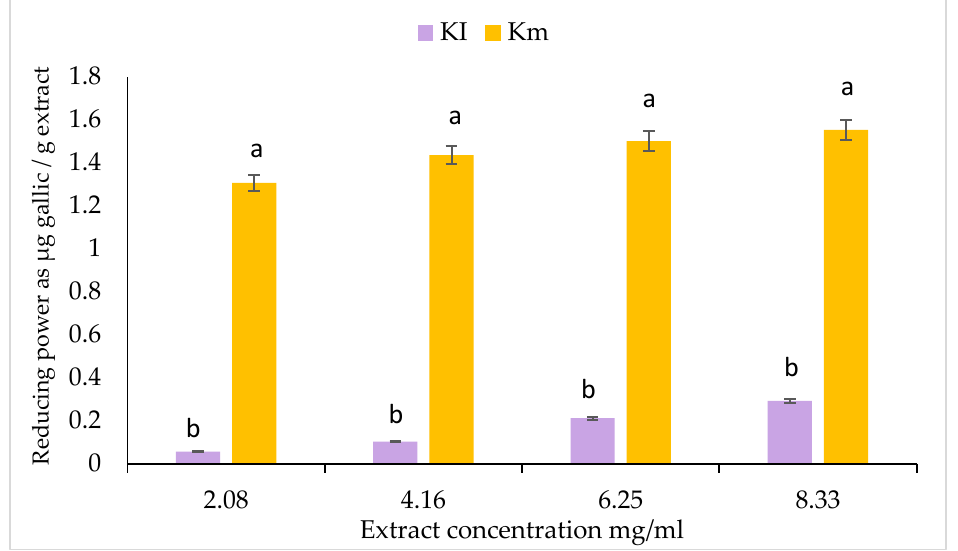
Figure 2. Reducing powers of mature (K m ) and immature (K I ) fruit extracts of K. pinnata . The values are the means of three replicates with standard deviation (±SD). Duncan’s multiple tests ( p ≤ 0.05) found no statistically significant differences between the values in each bar with the same letter.